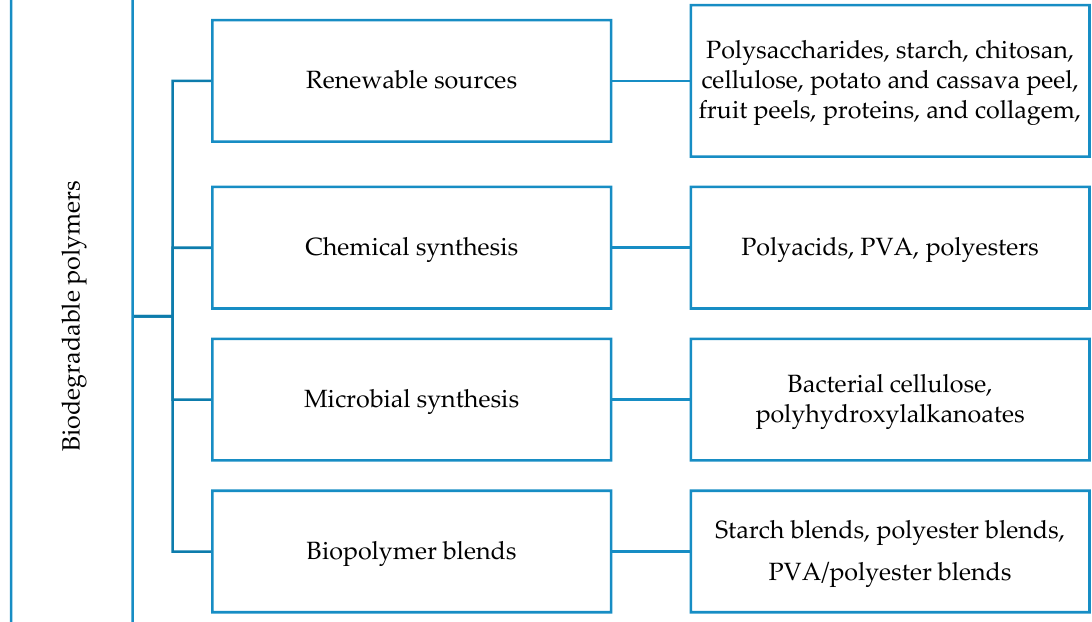
Figure 1. Classification of production processes for biodegradable polymers [18] (reproduced with permission from publisher). Table 1. Physical properties of di ff erent types of biopolymers